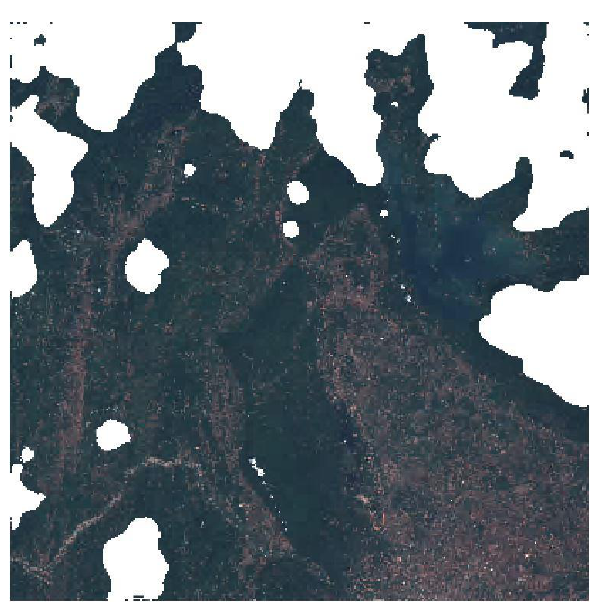
Figure 2: Cloud mask from prediction.